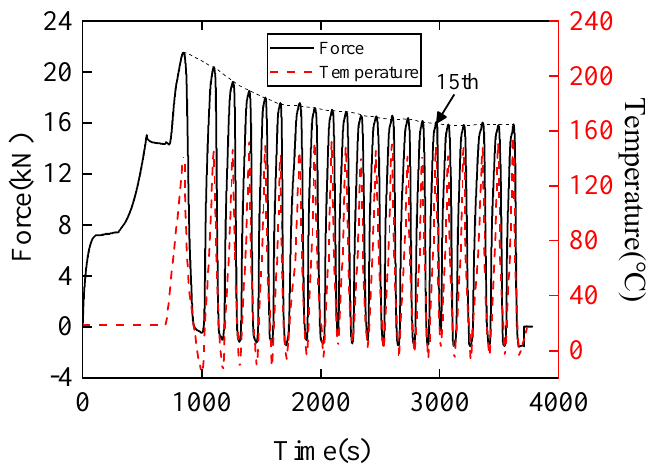
Figure 4. Loading and temperature variation curves of SMA strip during the training process.